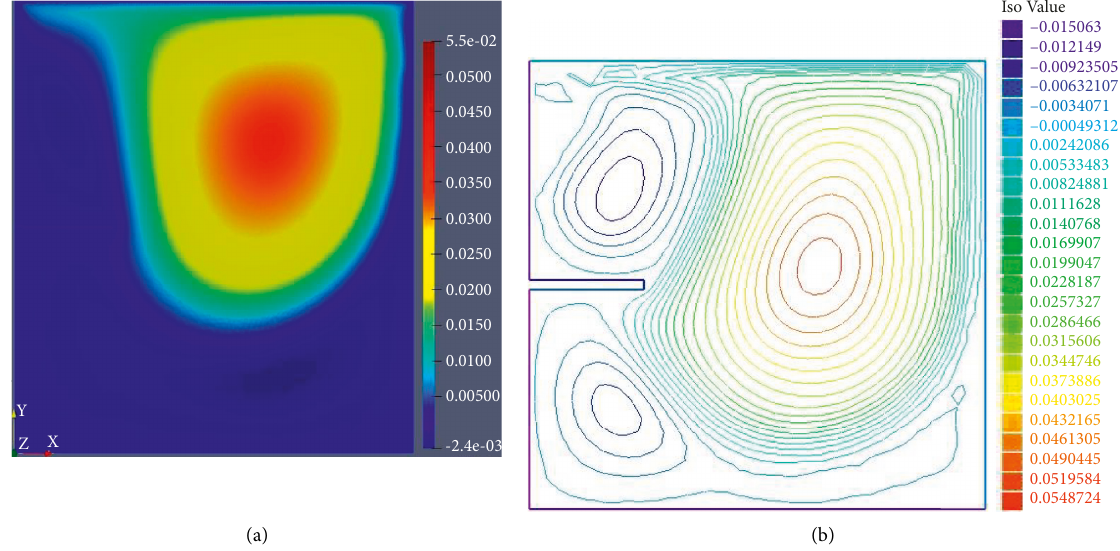
Figure 2: Stream velocity plot (a) and iso-lines of velocity magnitude (b) at two different time iteration levels.